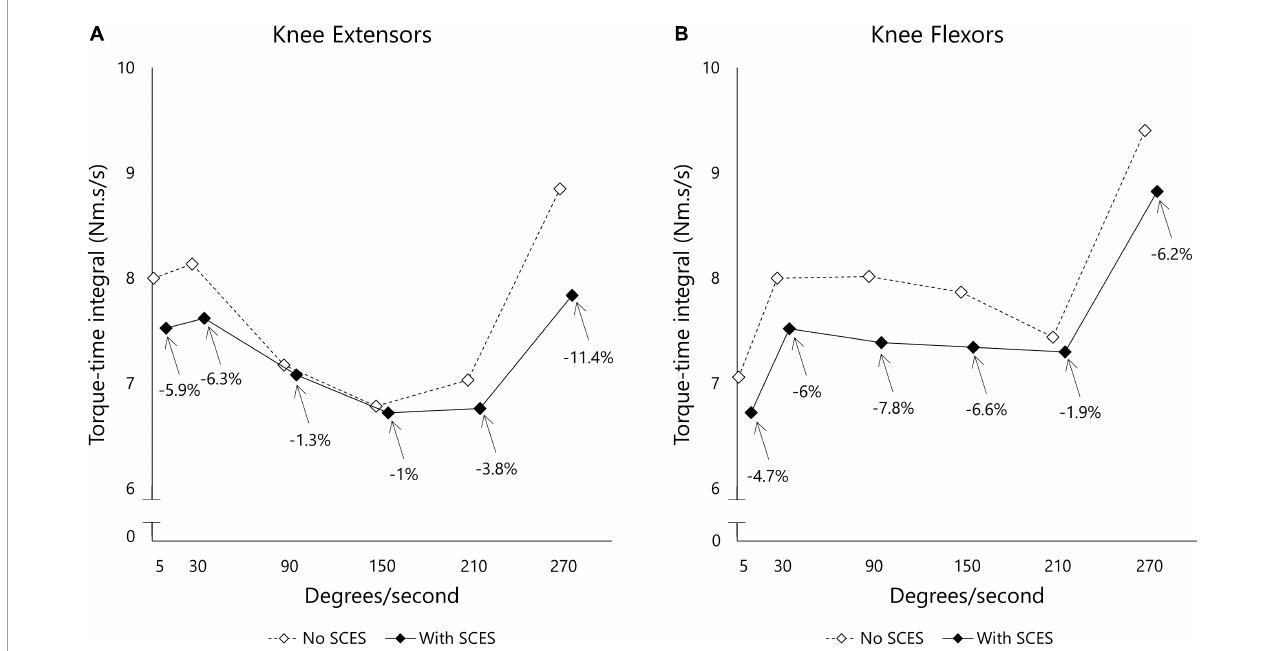
FIGURE6 Torque-time integral (Nm.s/s) measured for knee extensor (A) and flexor (B) muscle groups using isokinetic dynamometer. The examined leg was moved across different angular velocities (5–270 deg.sec - 1 ) and the resistance to passive movement was reported as area under the curve after accounting for the duration (s) of each curve. The task was administered initially with SCES off (open diamond) before a washout period of 30 min in which SCES was turned on (closed diamond).